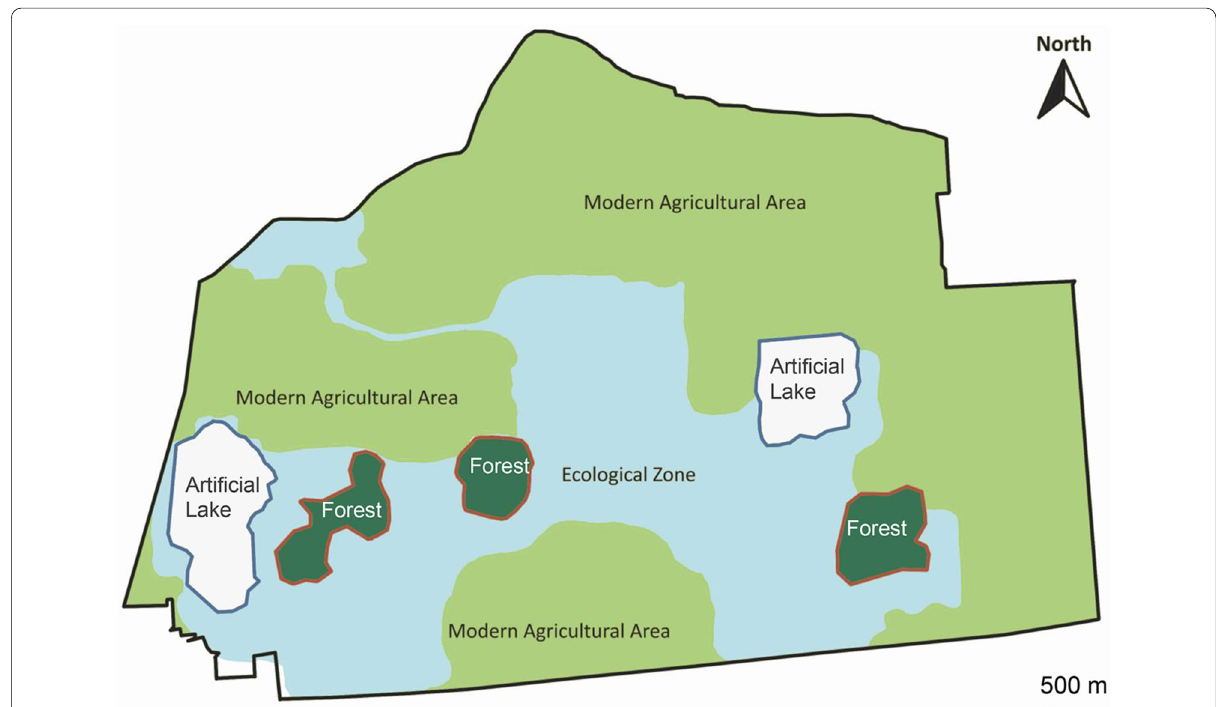
Fig. 6 Map showing the final plan for rehabilitation of the Dawu mining district, with different parts of the area allocated to artificial lake, forest, ecological (e.g., parks) and agricultural